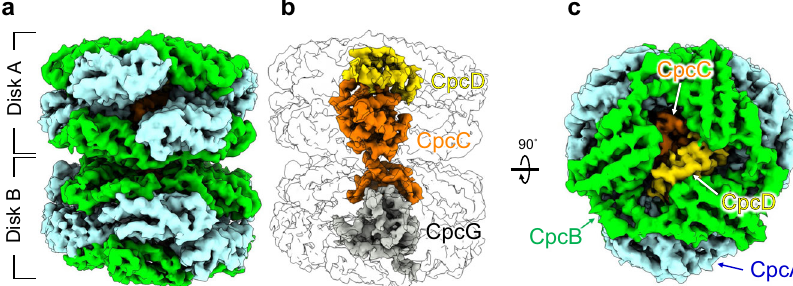
Fig. 6 Structure of PC rod including linker protein. a cryo-EM map of the PC rod (Disk A and Disk B). b Arrangement of the linker proteins (CpcC, CpcD, and CpcG) in the PC rod. c Structure of the PC rod in b rotated 90 ˚